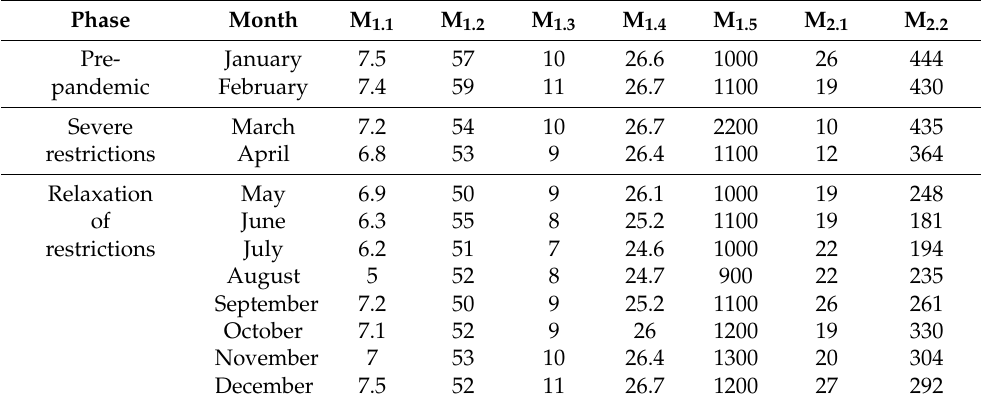
Table 6. Adverse conditions between January and December 2020 in the city of Natal-RN. Adverse